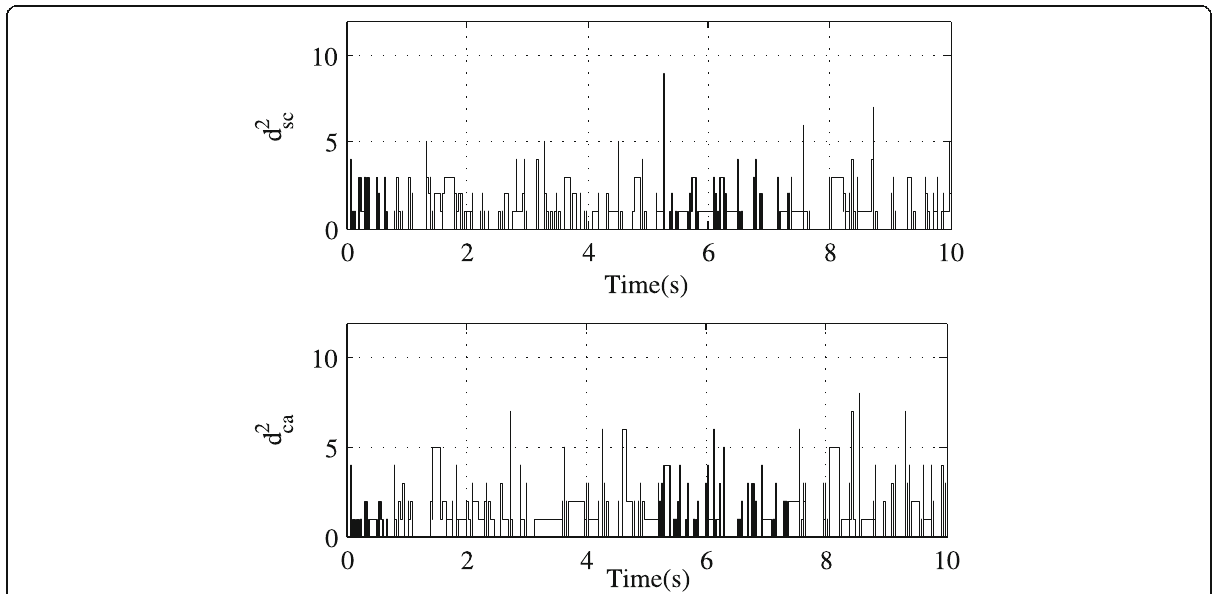
Fig. 14 The SC and CA packet dropout distributions of loop 2 when parameter perturbation and communication network